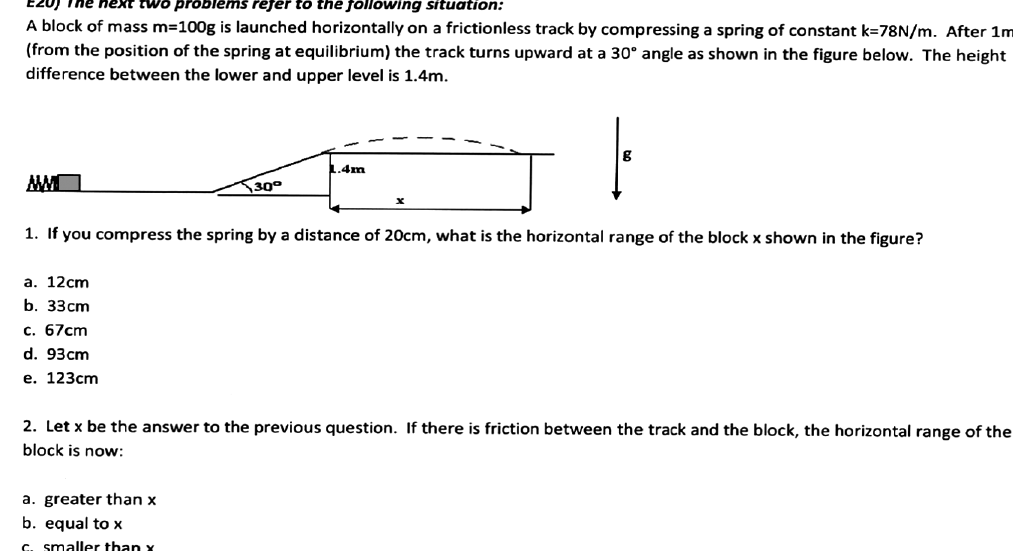
FIG. 1. Example problem